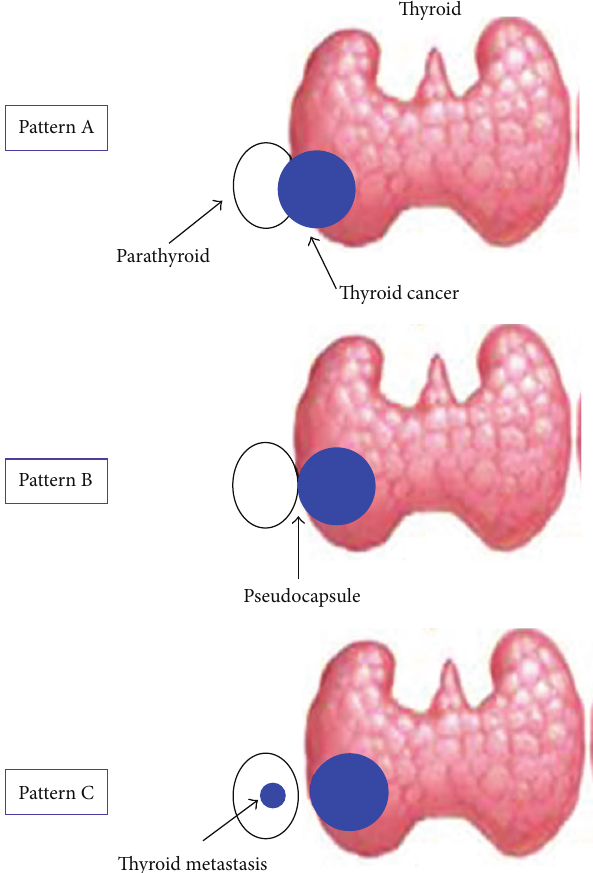
Figure 3: Patterns of parathyroid involvement by thyroid cancer. Pattern A: direct invasion by infiltrative growth from the primary thyroid neoplasm; Pattern B: extension of thyroid malignancy into the gland, from which cancer nests are separated by an intervening fibrous capsule (pseudocapsule); Pattern C: true metastasis within the gland, with no evidence of continuity from the primary thyroid